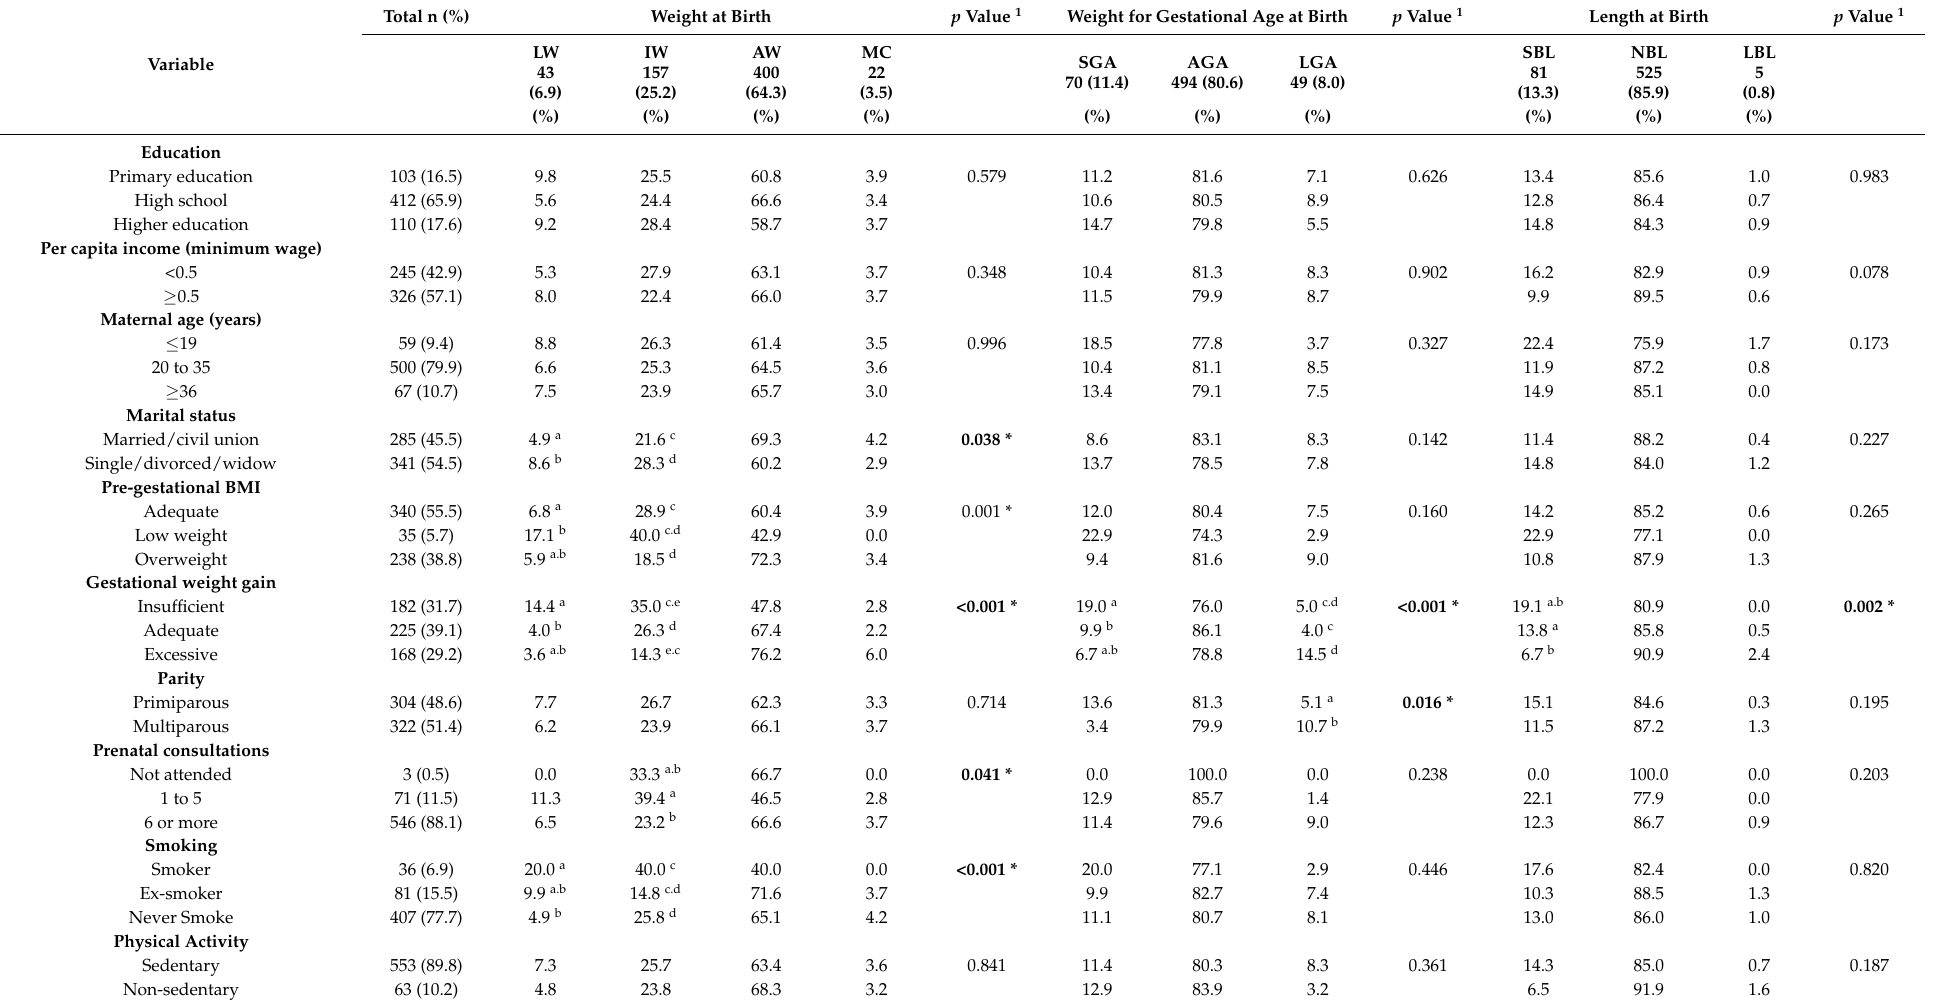
Table 1. Anthropometric measurements of the baby according to socioeconomic and demographic, gestational, prenatal, and maternal lifestyle characteristics and the tertiles of ultra-processed foods consumption during pregnancy